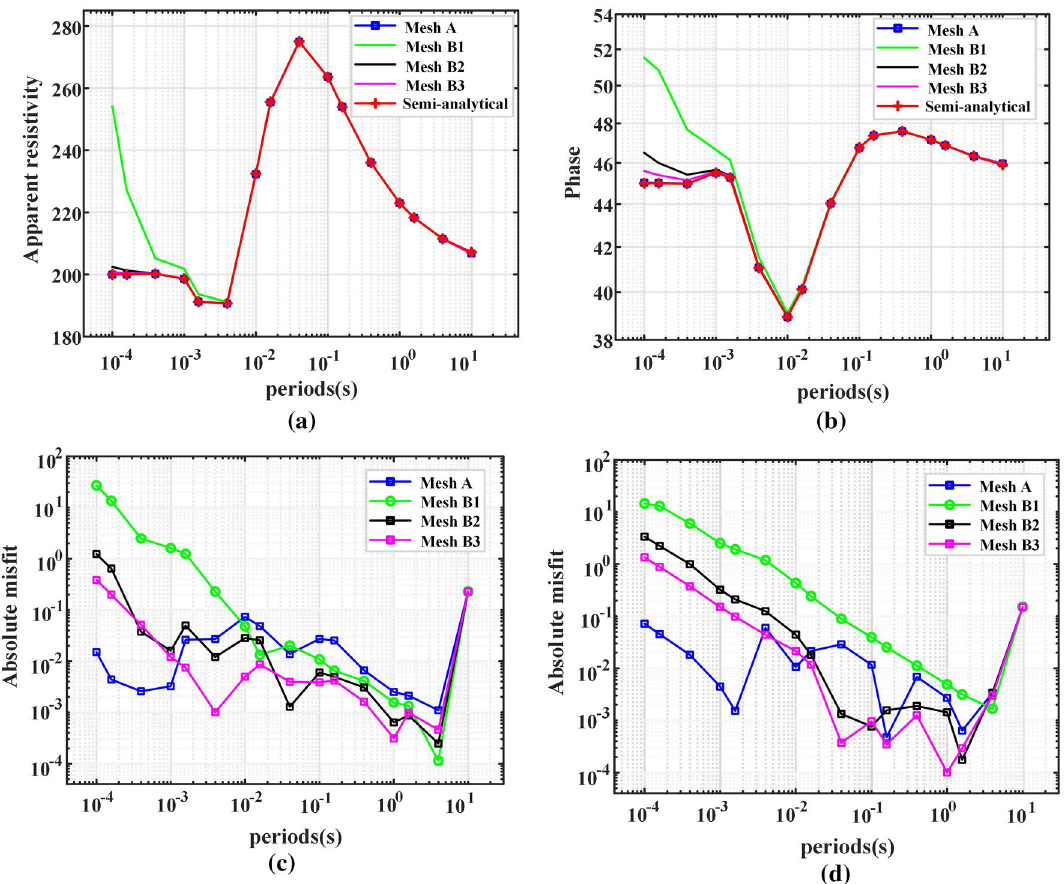
Figure 9. The MT responses of the three-dimensional layered model calculated with different meshes. Apparent resistivities and phases are shown in ( a ) and ( b ), respectively. The misfits of the apparent resistivities and phases are shown in ( c ) and ( d ), respectively. The absolute misfit is normalized by the semianalytic solution.